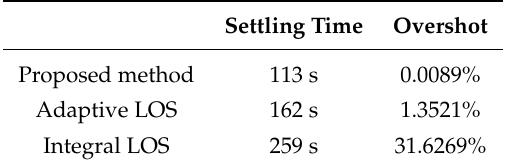
Table 1. Comparisons of path-following performance in transient